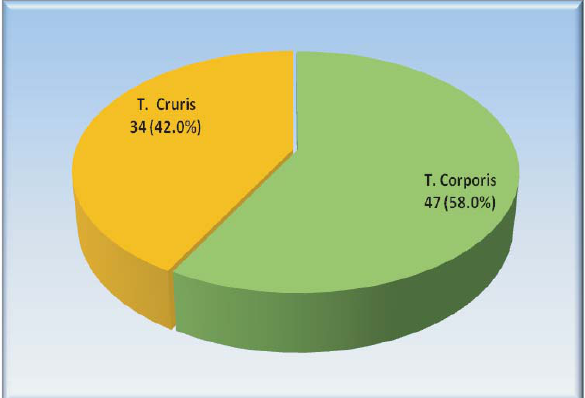
Fig 1. Distribution of the patients by clinical types of dermatophytosis (n=81)